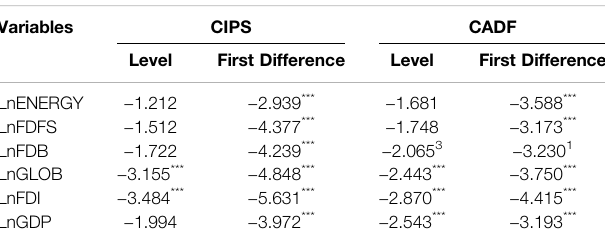
TABLE 3 | Panel unit root test.